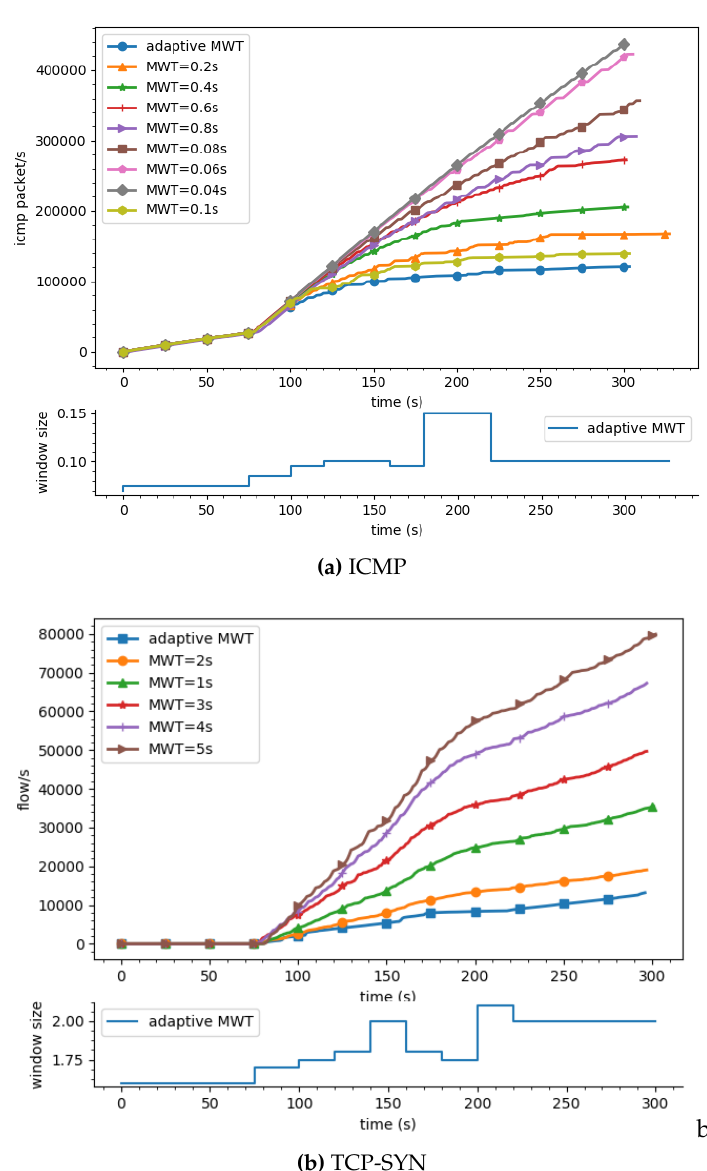
Figure 9. Mitigation efficiency depending on monitoring window time in two cases: ( a ) ICMP Flood attack and ( b ) TCP-SYN